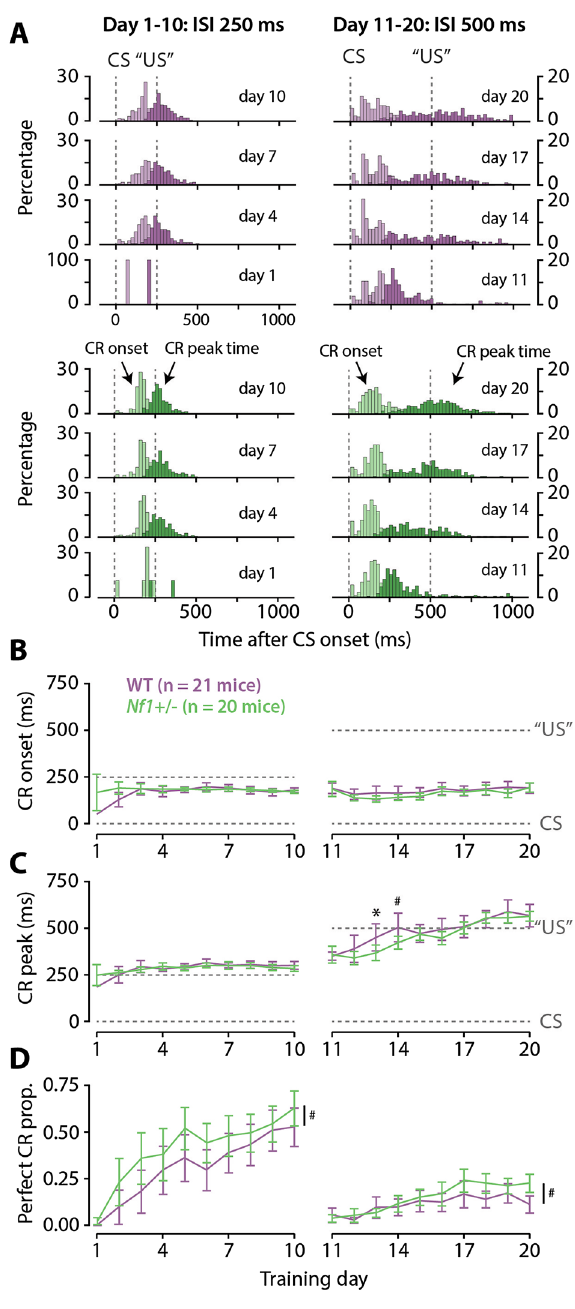
Figure 3. Timing of conditioned eyeblink responses. ( A ) Histograms of the timing of conditioned responses (CR) per genotype and training day (first and subsequent third day). ( B ) Average timing of CR onset. ( C ) timing of CR peak. The left column of figures describes the 250 ms ISI training phase, where the right column describes the subsequent 500 ms ISI training phase. ( D ) Proportion of perfectly timed CRs, i.e., CRs whereby the peak fell within a window of max 50 ms plus or minus the omitted US onset. Green data represents Nf1 +/− mice. Purple data represents WT mice. # Trend towards a significant difference between genotypes of p < 0.1; *Significant difference between genotypes of p < 0.05. All error bars represent 95% confidence